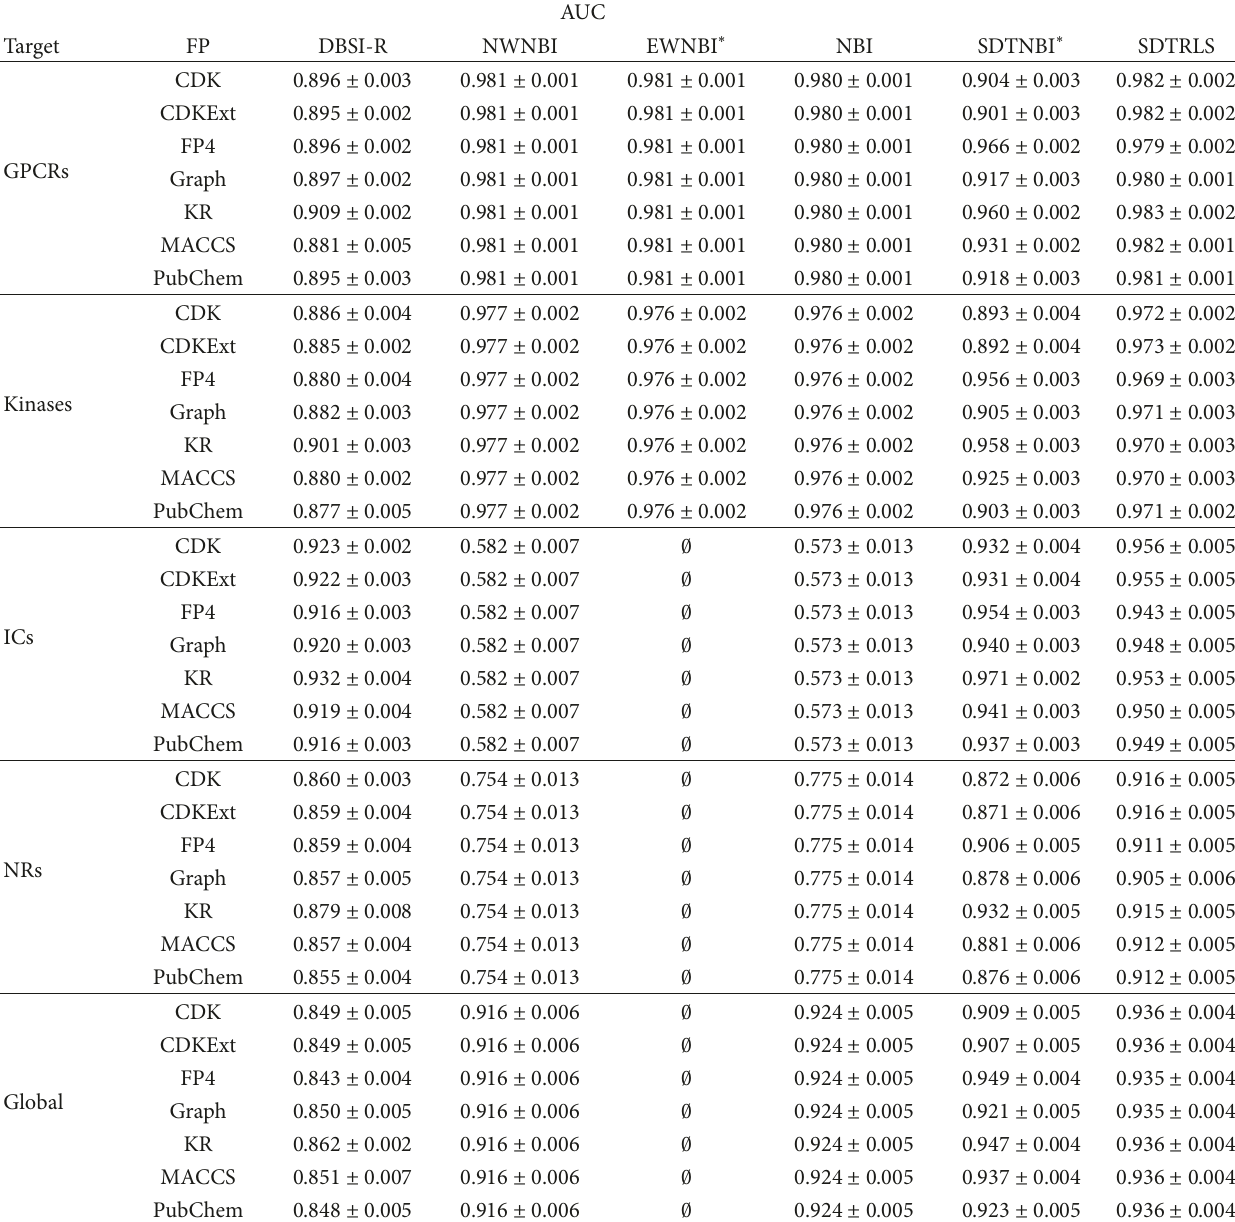
Table 3: The performance of 10-fold cross validation on 5